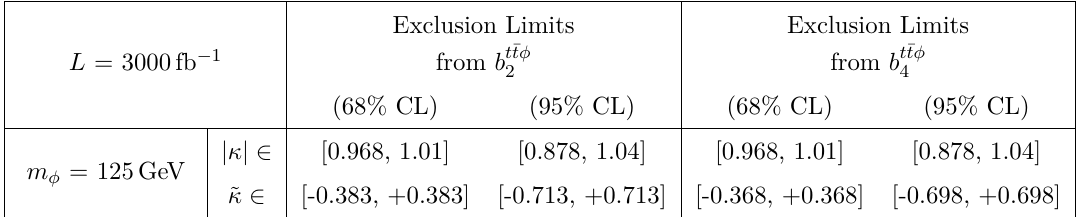
and b t ¯ tφ , at the 2 4